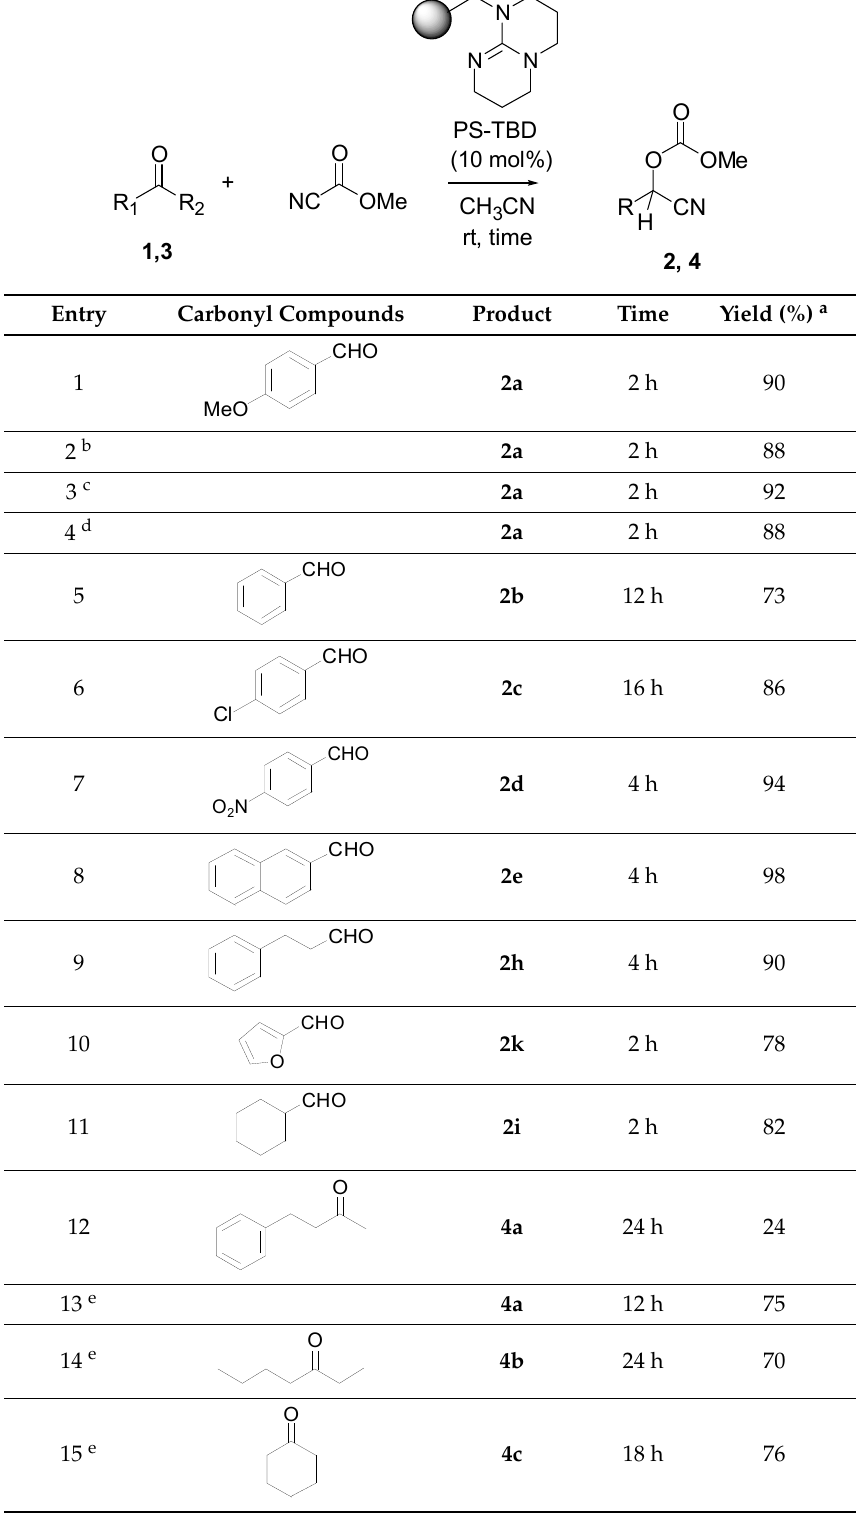
Table 4. PS (polymer-supported)-TBD catalyzed cyanation of carbonyl compounds with methyl